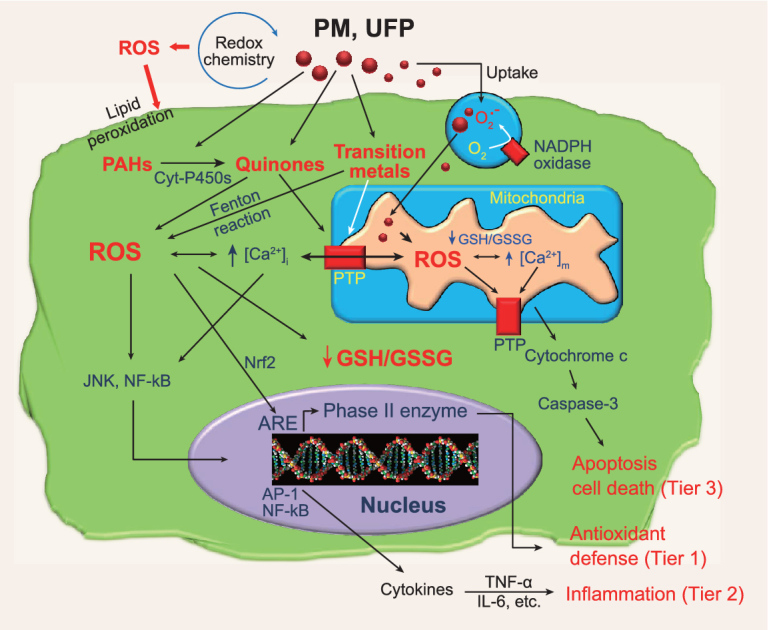
Sources of PM- and UFP-induced ROS production and their cellular effects. Quinones, under the catalytic influence of NADPH-cytochrome P450 reductase, can redox cycle to produce ROS in the endoplasmic reticulum. Phagocytosis can induce the assembly and activation of NADPH oxidase to produce superoxide. UFPs can interfere in electron transduction in the mitochondrial inner membrane as well as perturb the PT pore to generate ROS. ROS induce lipid peroxidation in the cell membrane, cross-linking of protein thiol (SH) groups and DNA damage. ROS can also deplete glutathione (GSH), resulting in oxidative stress in the cell. Depending on the levels of oxidative stress, the response could range from induction of Nrf2 release to the nucleus, activation of MAPK and NF-kB signaling cascades, or cytotoxicity. According to the hierarchical oxidative stress hypothesis, Nrf2 interaction with the antioxidant response element (ARE) leads to heme oxygenase 1 and other phase II enzyme expression at lower levels of oxidative stress (Tier 1), while, at a intermediary level of oxidative stress, activation of the MAPK and NF-kB signaling cascades can induce pro-inflammatory responses (e.g. cytokine and chemokine production) (Tier 2). At the highest oxidative stress level (Tier 3), ROS can induce the opening of the mitochondrial PT pore, followed by cytochrome c release, caspase-3 activation and induction of programmed cell death.